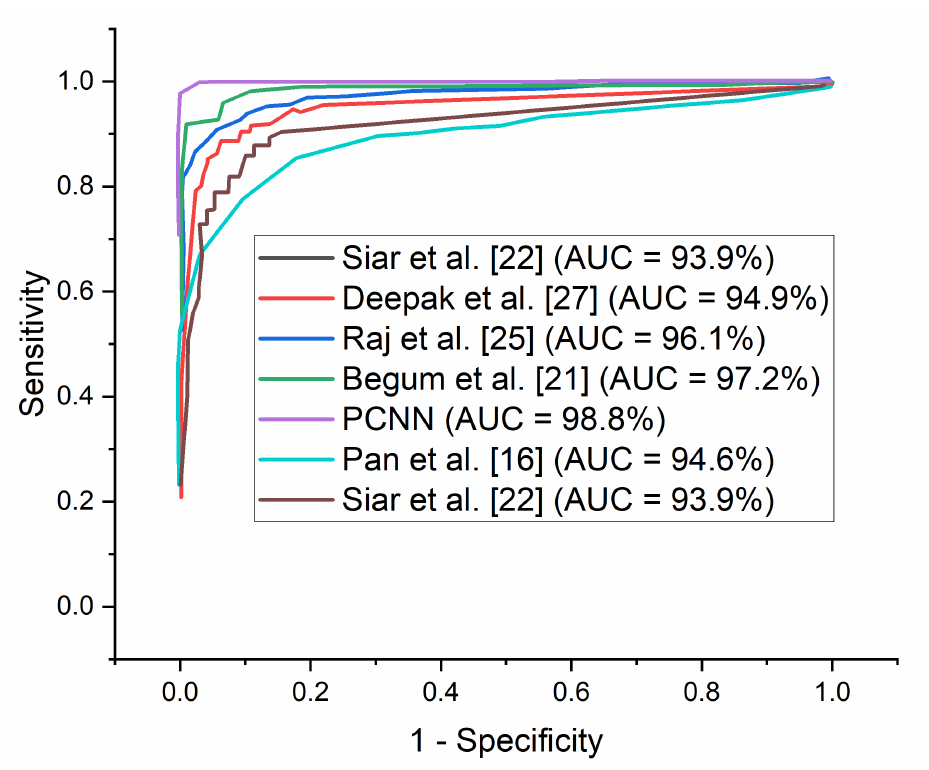
Figure 10. ROC-AUC curves for the proposed PCNN in comparison with some selected state of the art models using the same dataset.